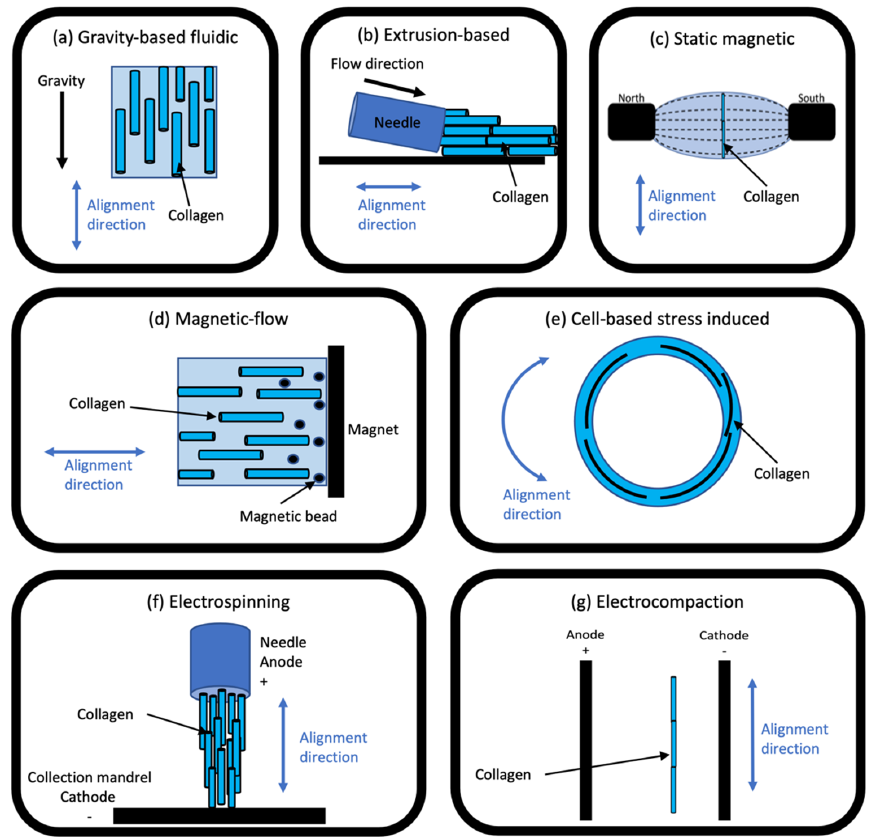
Figure 3. Schematic of collagen alignment methods: ( a ) gravity-based fluidic, ( b ) extrusion-based, ( c ) static magnetic, ( d ) magnetic-flow, ( e ) cell-based stress induced, ( f ) electrospinning, and ( g ) electro-compaction.